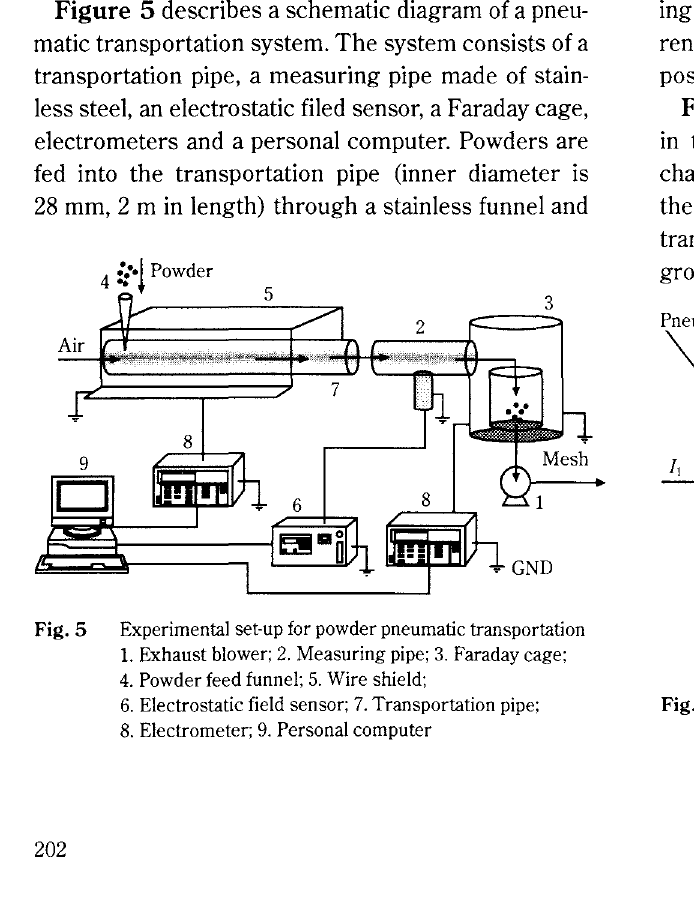
The powder charge model for pneumatic transportation